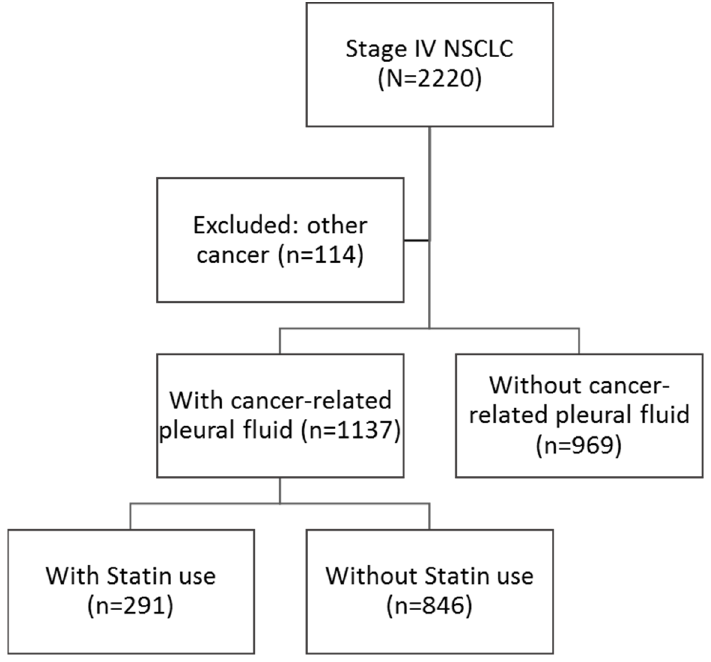
Figure 6. Study flow of NSCLC stage IV patients with cancer-related pleural effusion.